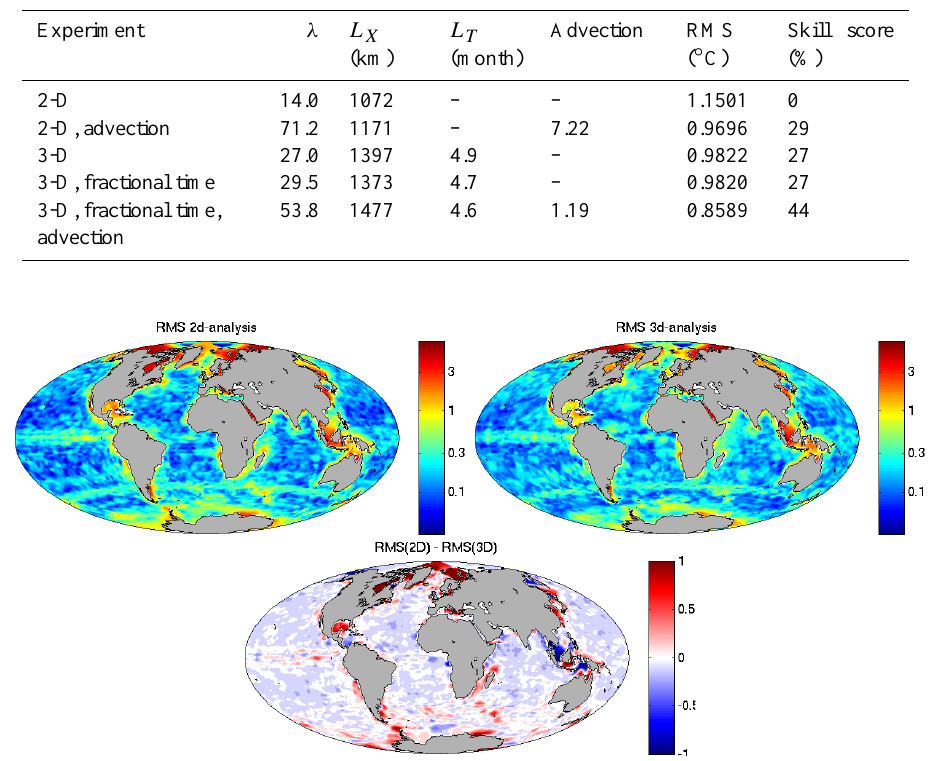
Fig. 5. Top left: RMS difference (averaged over time) between the 2-D analysis and the model reference climatology. Top right: idem for 3-D. Bottom: difference of RMS error of the 2-D analysis minus the RMS error of the 3-D analysis.